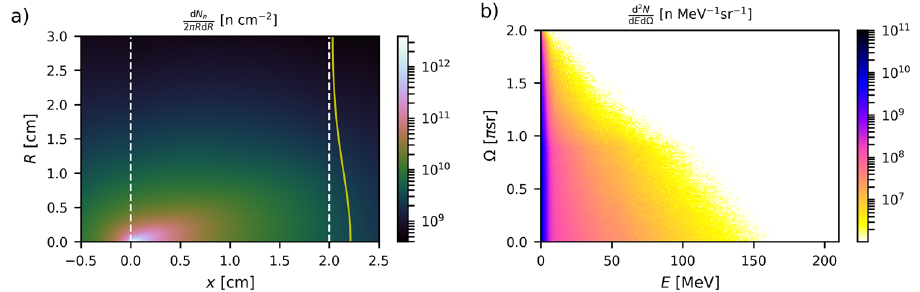
Figure 7. Neutron fluence profile across the converter and energy-angle spectrum of the outgoing neutrons. ( a ) Spatial distribution of the neutron fluence through a 2-cm-long lead converter. The white dashed lines indicate the front and rear sides of the converter. The primary protons, injected from the left side, are those accelerated in PIC run #3 (see Table 1). The yellow line is a Gaussian fit (with a FWHM width w n = 2.3cm ) of the neutron fluence as recorded at the converter’s backside ( x = 2cm ). ( b ) Energy-angle spectrum of the outgoing